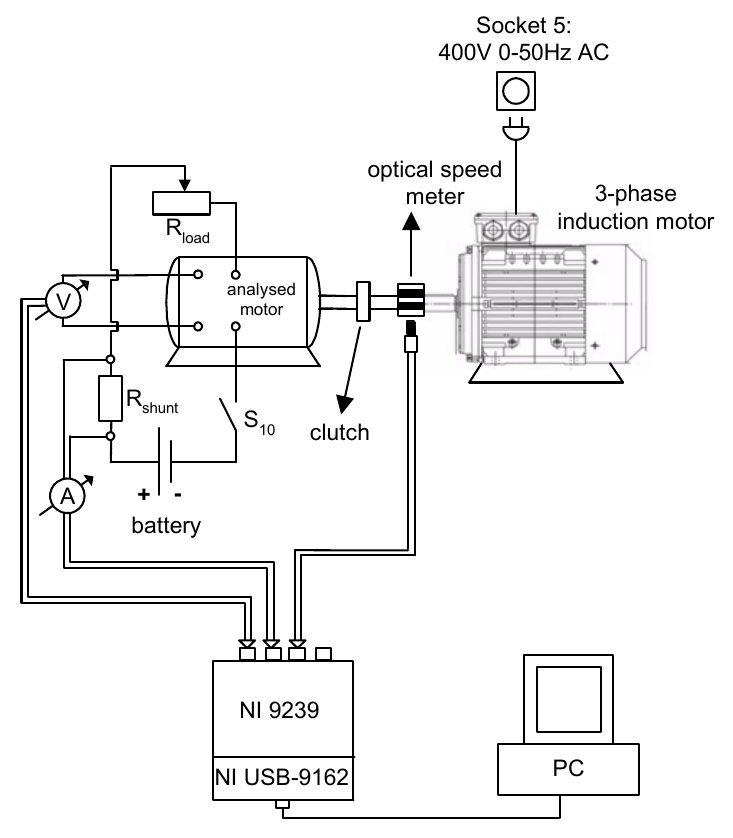
Figure 18. Experimental setup for measuring the mutual dynamic inductance between the stator and rotor windings of a series-wound DC motor.